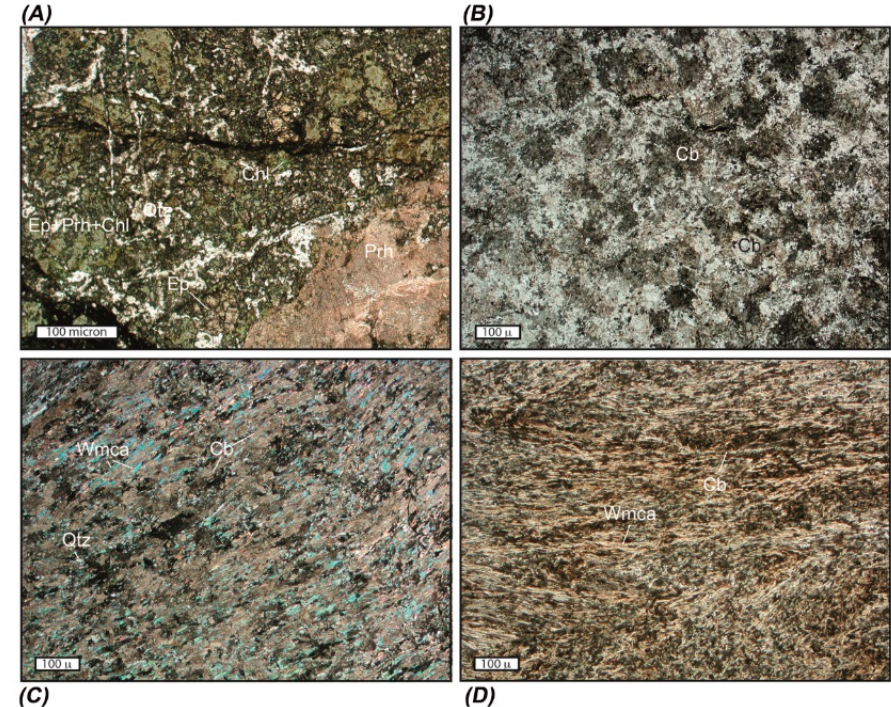
Figure 13. Di ff erent types of alteration mineralogy in hydrothermally altered rocks. Microphotographs of ( A ) epidote + prehnite + chlorite-dominated alteration in the damage zone of a fault in Glasgow Volcanics (plane-polarized light; #09.12.03GL 9); ( B ) carbonated basalt in the damage zone of a shear zone (Dorn Glacier—plane-polarized light; #08.12.05GL6); and ( C , D ) foliated listvenites from two brittle-ductile shear zones at the WT-BT boundary ( C : crossed-polarized light, #23.12.96 GL 6; D : plane-polarized light, #19.12.96 GL 6). Abbreviation: Ep = epidote, Prh = prehnite, Chl = chlorite, Cb = carbonate, Wmica = white mica, Qtz = quartz.